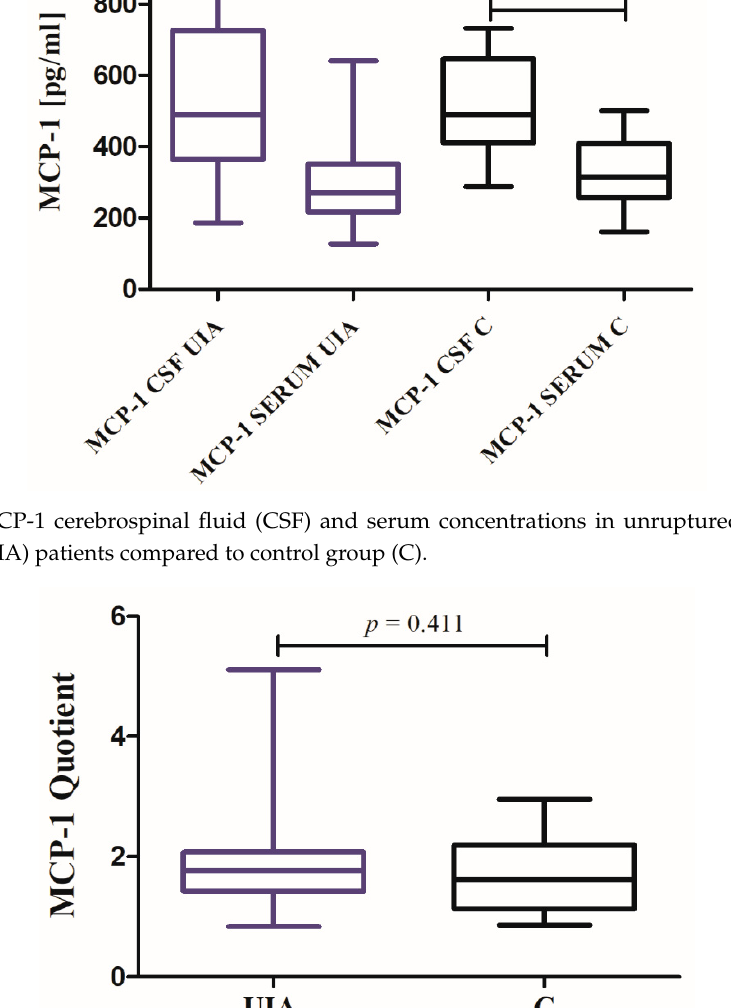
Table 4. Univariate logistic regression analysis results for UIA diagnosis.